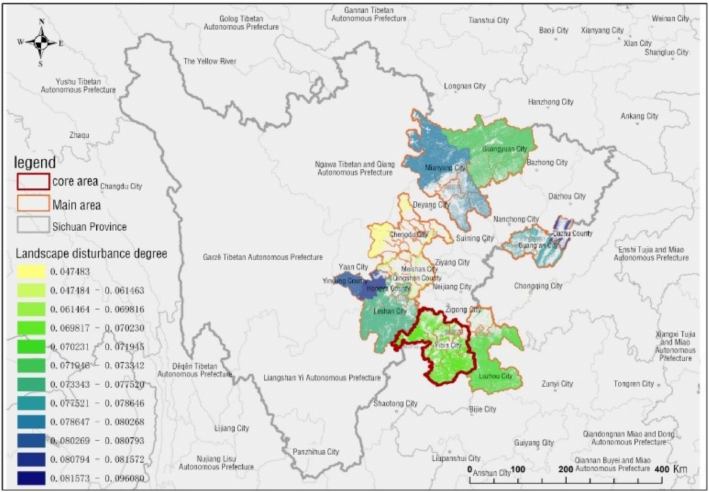
Figure 18. Landscape pattern index (landscape disturbance degree) of research areas in Sichuan Province.